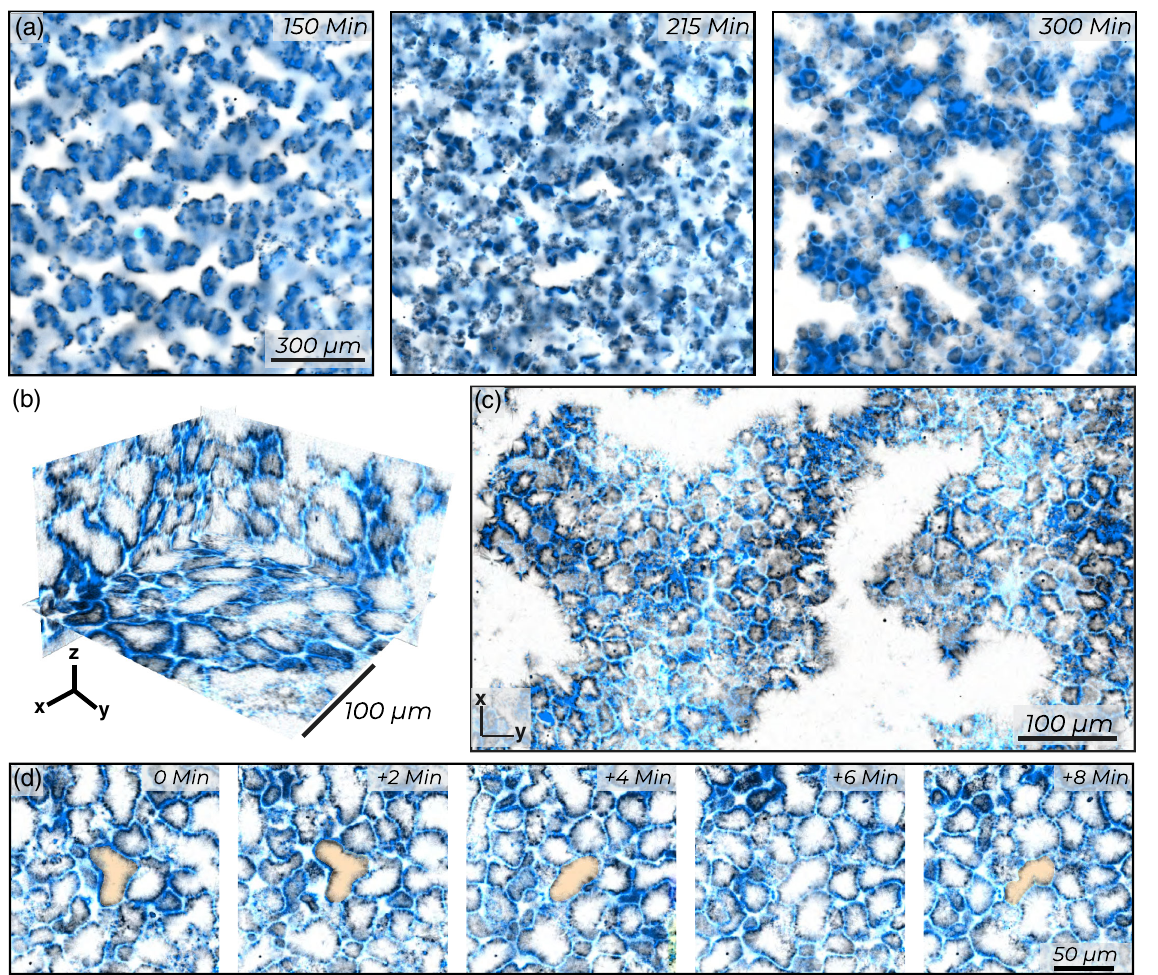
FIG. 7. Active foam: Surface roughening yields an active foam. (a) Morphological change from monolayer envelopes to a percolated foam. (b) Ortho-slices show the complex 3D structure of the active foam. (c) Maximum intensity z projection over 10 μ m illustrates distinct foam cells which can have free ends or open faces. (d) A foam cell undergoes topological rearrangements in an active foam. Samples are constituted from 200 nM kinesin (blue) and 40 μ M tubulin